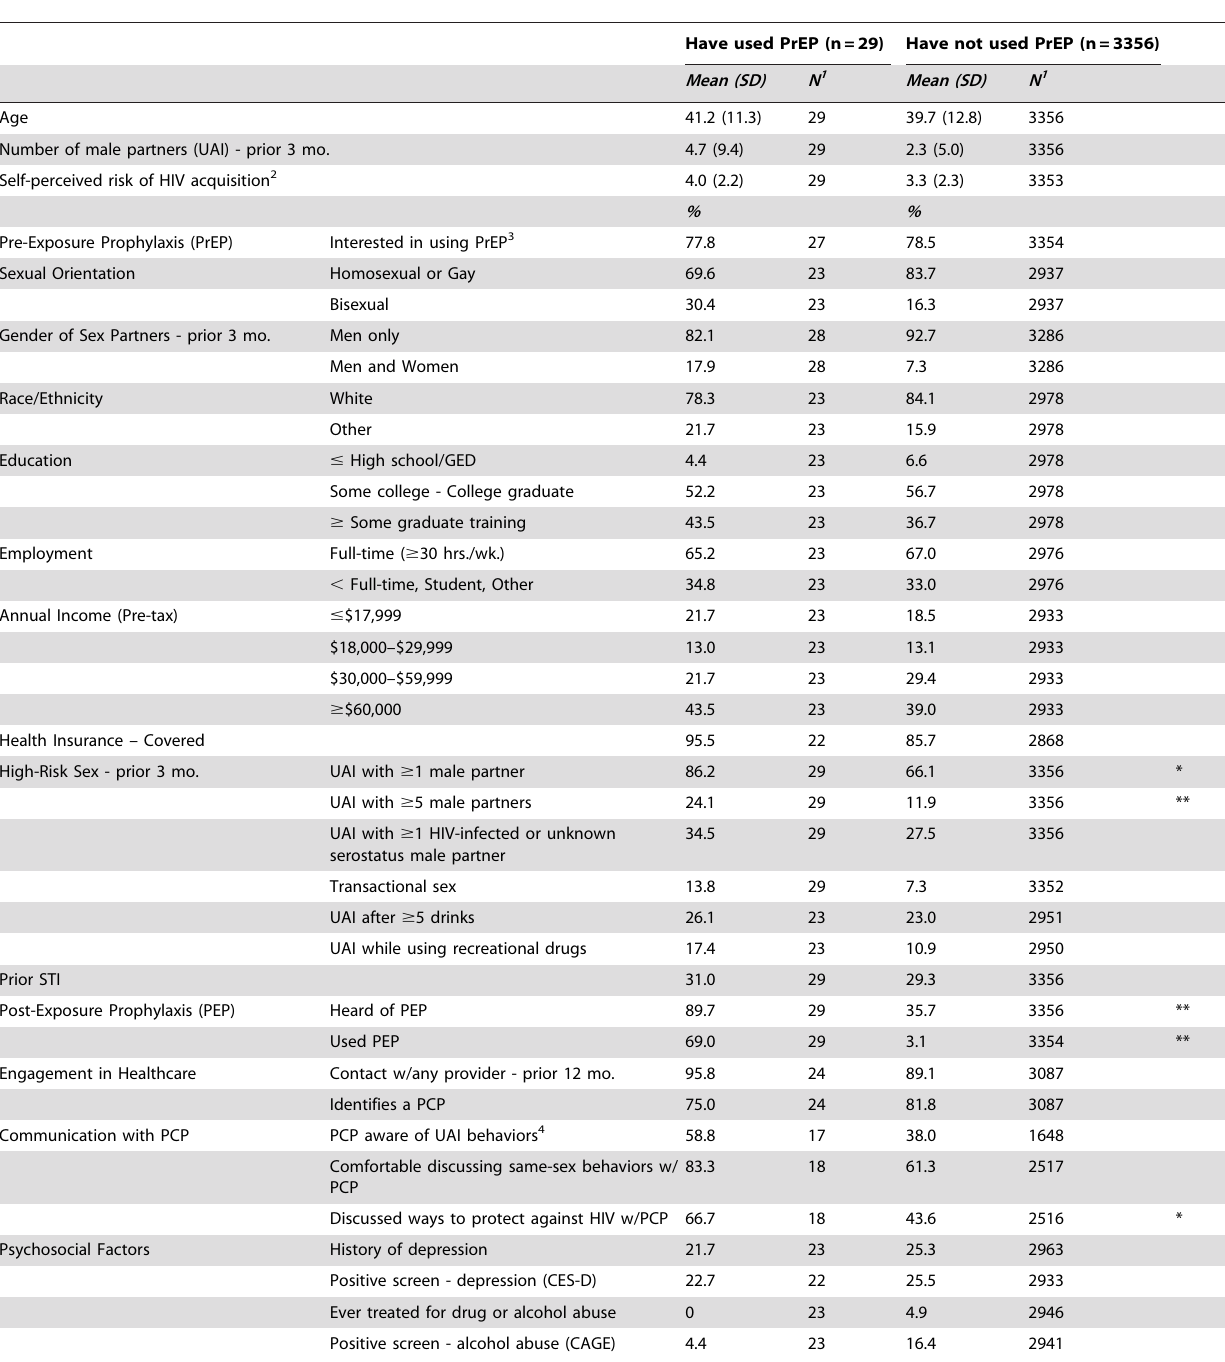
Table 4. Characteristics of Participants Reporting Use of Pre-Exposure Prophylaxis (n=29) compared to Non-Users (n= 3 356) One Month after Publication of Efficacy Results (the iPrEx Study).